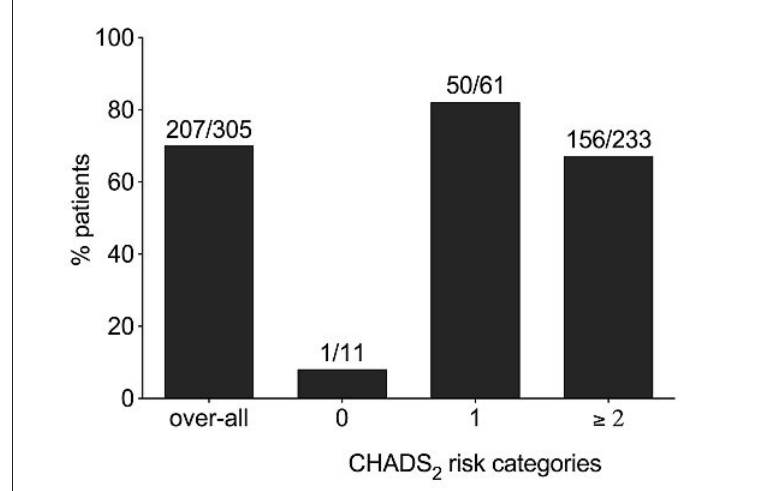
Figure 2 Number of patients treated according to guideline recommendations.